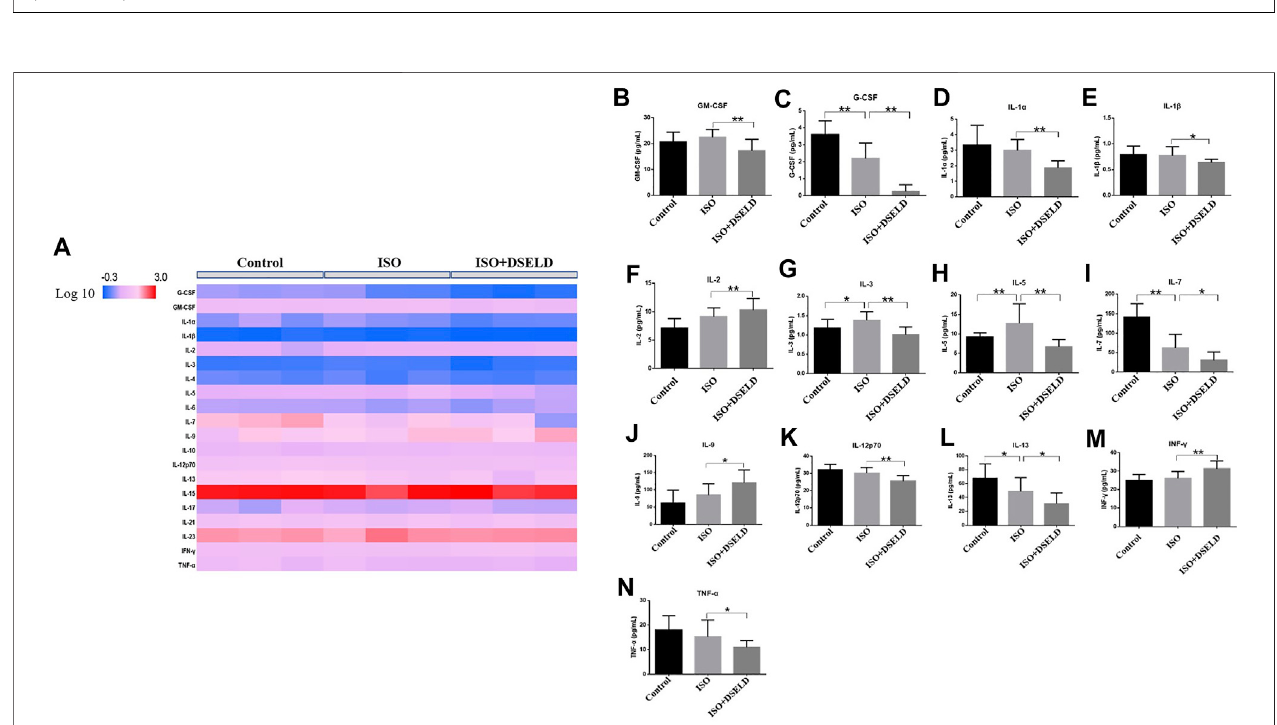
FIGURE 5 | Multiple in fl ammatory cytokines in heart failure (HF). (A) Cytokine pro fi ling of heart samples obtained from the different treatment groups. (B – N) Cytokine concentrations in heart samples from different treatment groups of mice, n (cid:1) 4. *p < 0.05, **p < 0.01.